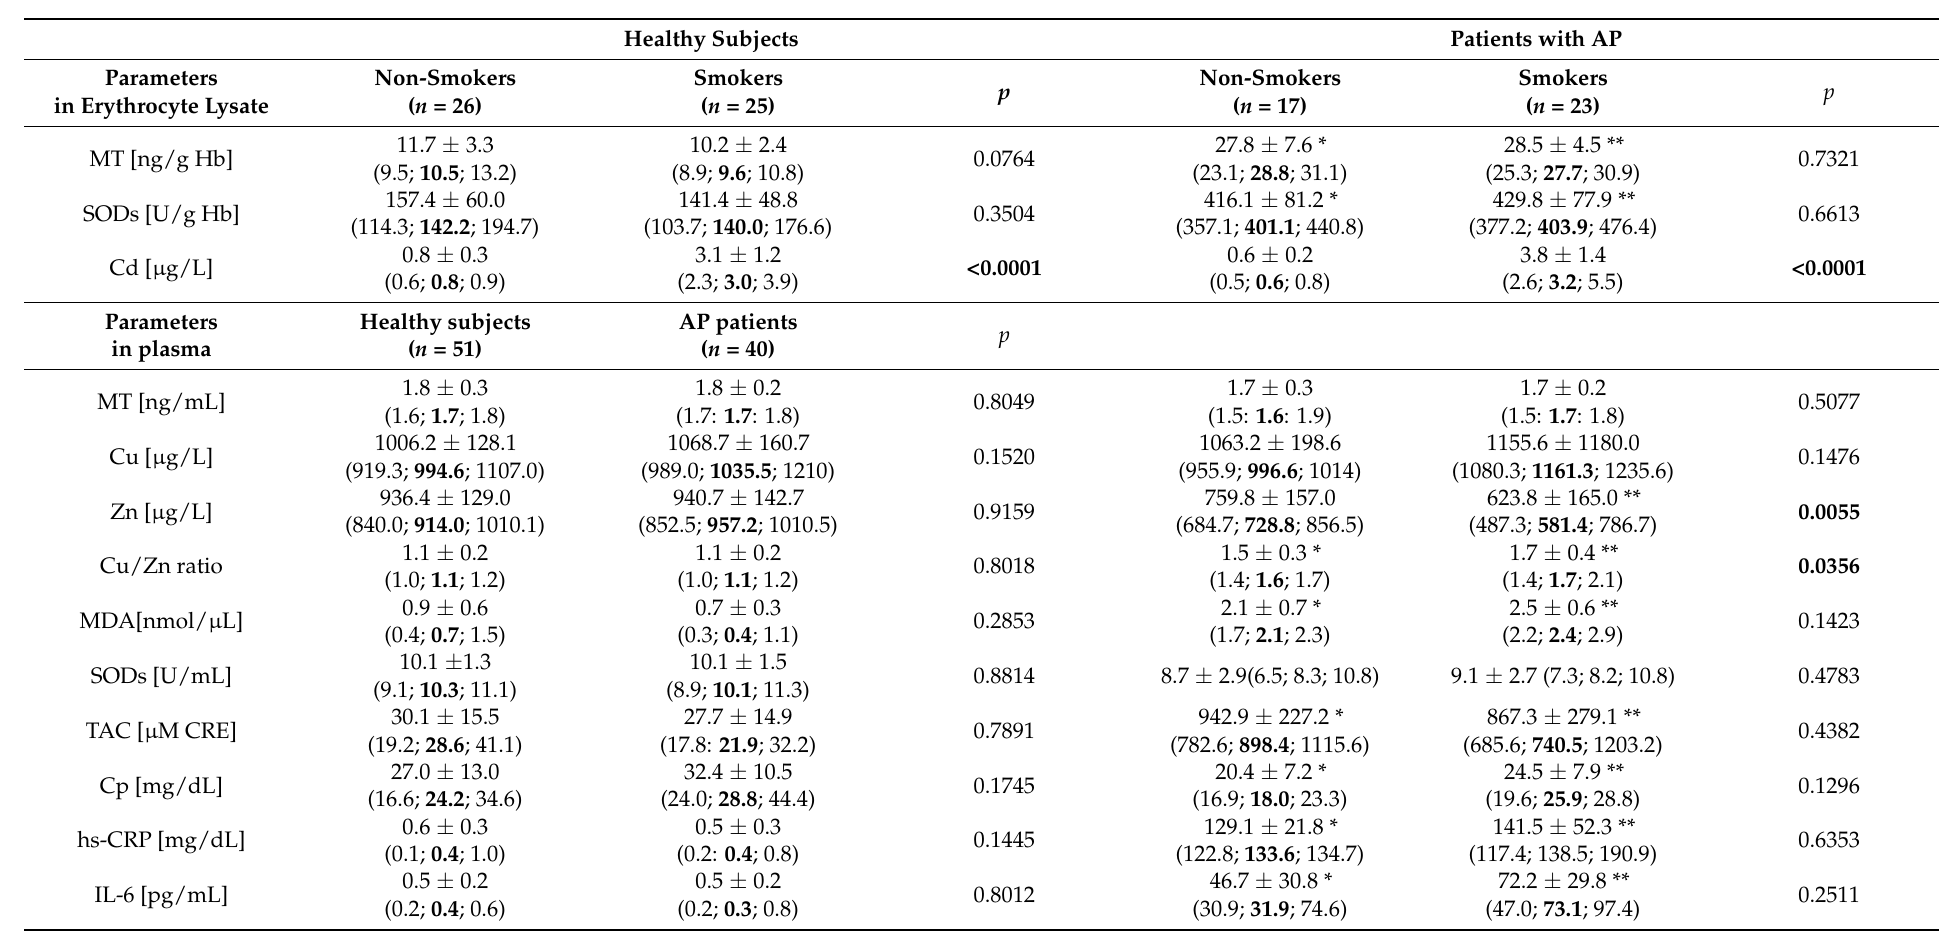
Table 1. The concentration of metals (Cu, Zn and Cd), MT, Cp and markers of inflammation and oxidative stress in groups of non-smoking and smoking healthy subjects and AP patients. The bold is to distinguish the median values and p -values indicating the statistically